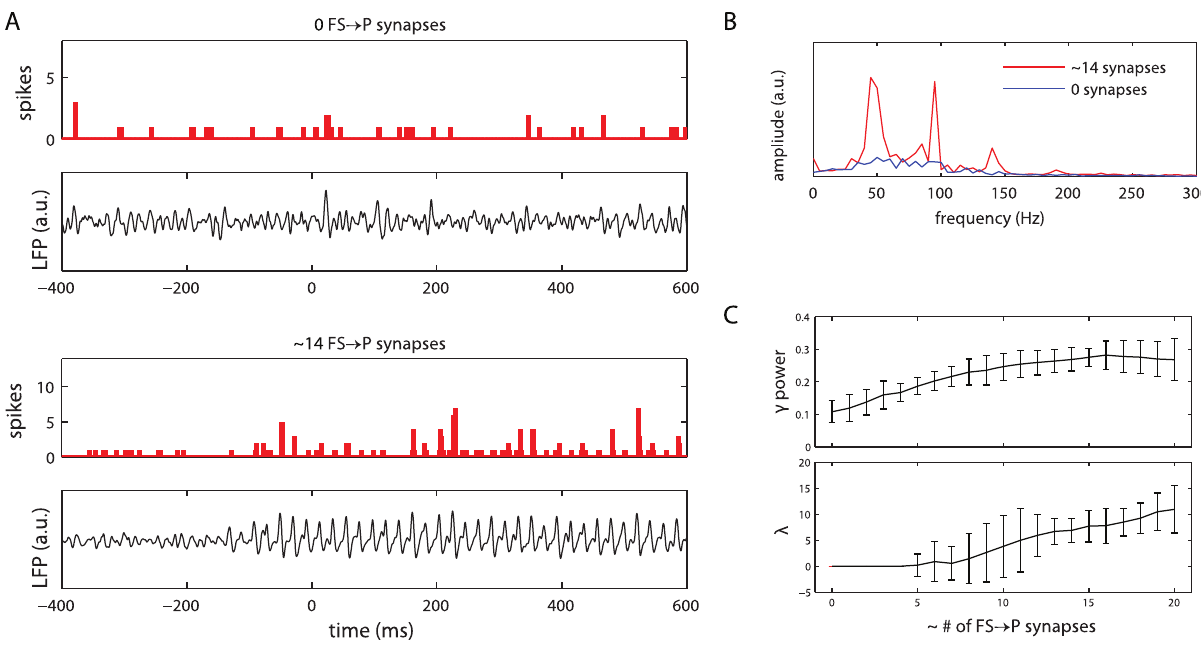
Figure 3. Pyramidal cells show gamma-synchronized activity when cells receive shunting inhibition. (A) Spike histograms and simulated LFP traces for the unconnected ( 0 FS to P synapses per P -cell) and connected ( 14 FS to P synapses per P -cell) conditions. Other input to the P -cells consisted of constant-rate Poisson spike trains. (B) Amplitude spectra for the simulated LFP in the connected (red) and unconnected (blue) conditions. The LFP spectrum for the connected condition shows a clear increase in power in the gamma band (30–80 Hz). (C) Relative gamma band power (top) and pyramidal cell network synchronization (bottom) as a function of the average number of GABA -ergic projections from the FS cells to a single P -cell. Relative gamma power increases steadily with the number of synapses, reaching a maximum at § 15 synapses per P -cell. Network synchronization starts to occur at § 5 synapses per P -cell. Shown are the mean values for 30 simulation runs; error bars represent 95% confidence